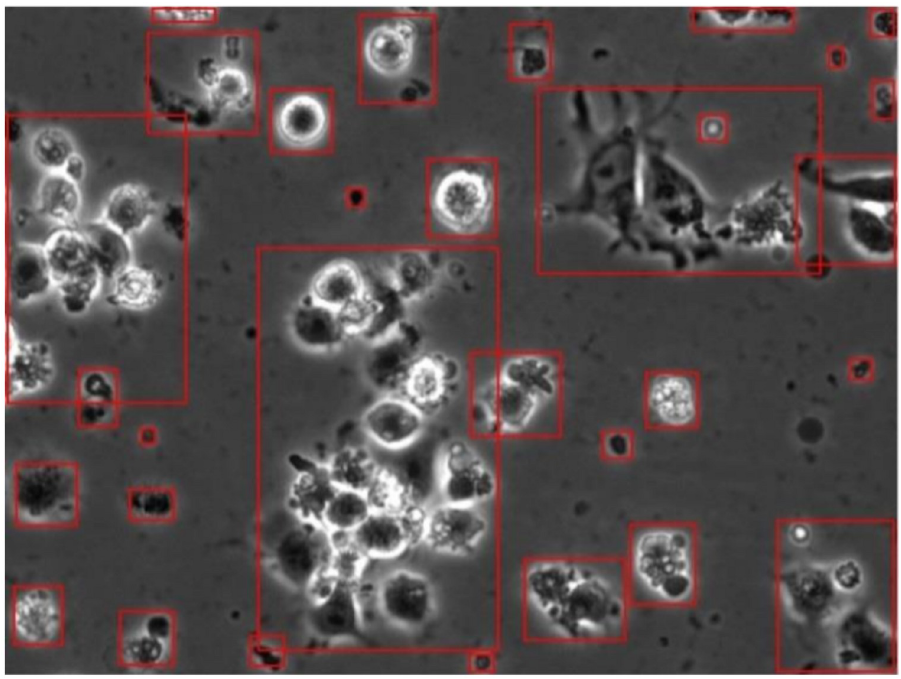
Fig 7. Detected cell bodies of a single frame using the approach proposed by [24]. The detected cell bodies are then cropped and passed through the hierarchical classifier to be classified into one of the aforementioned six classes.